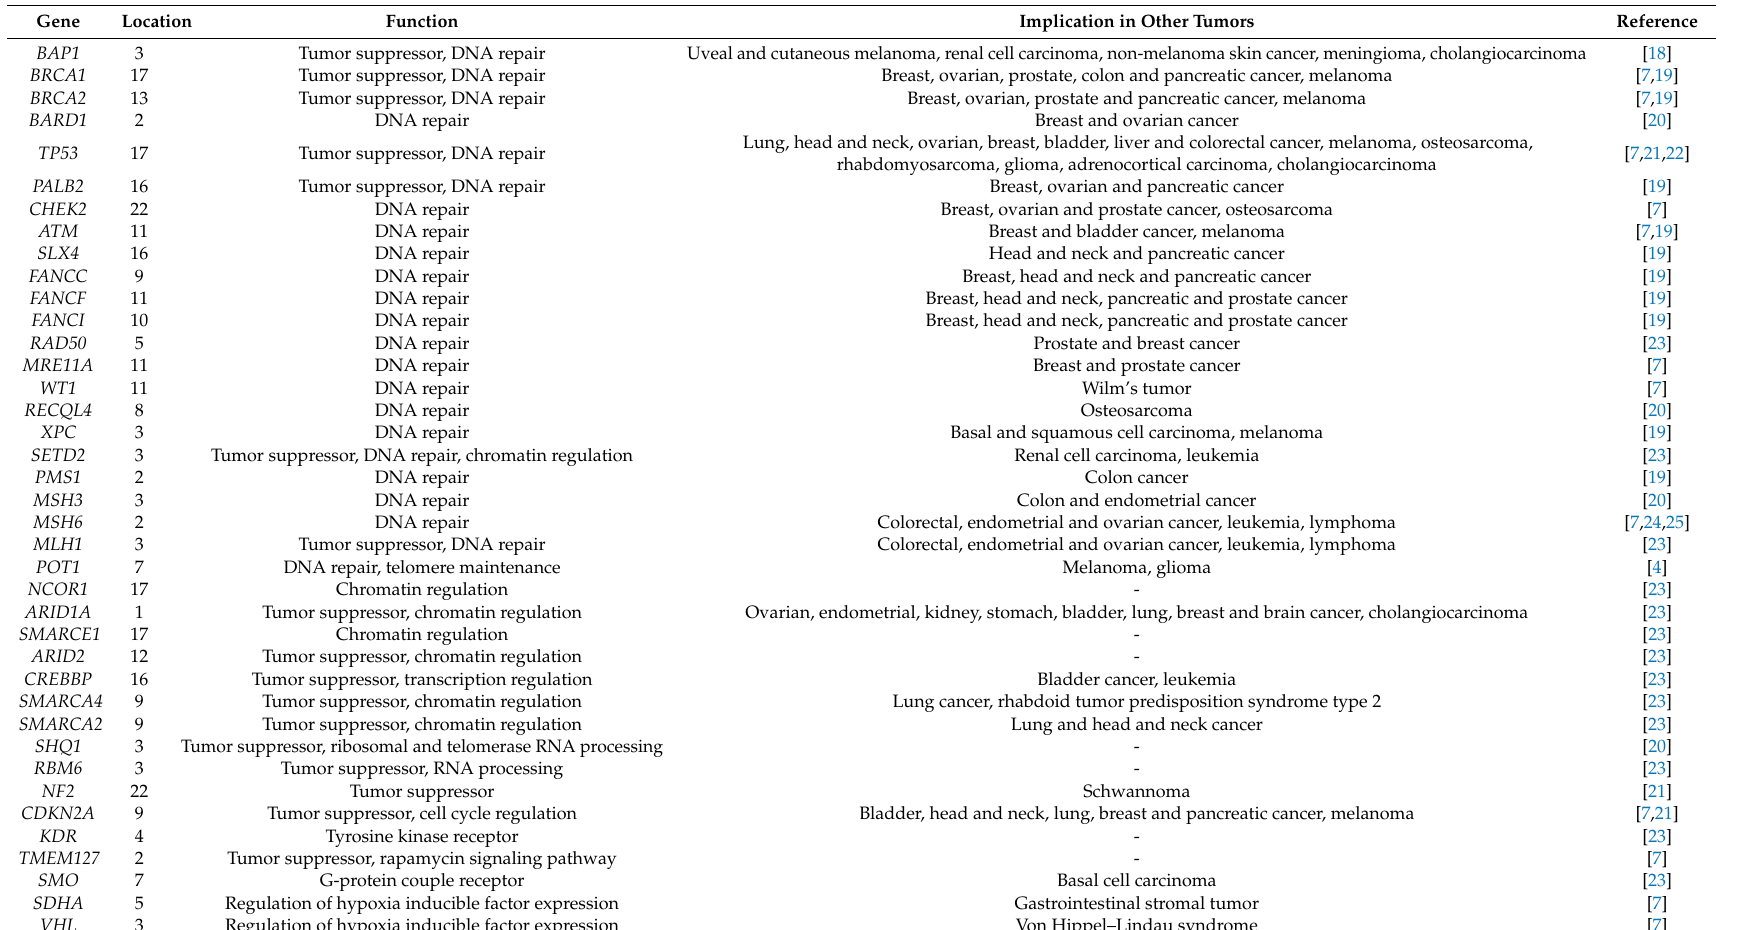
Table 1. Pathogenic or likely pathogenic germline mutations associated with malignant mesothelioma*. Gene Location